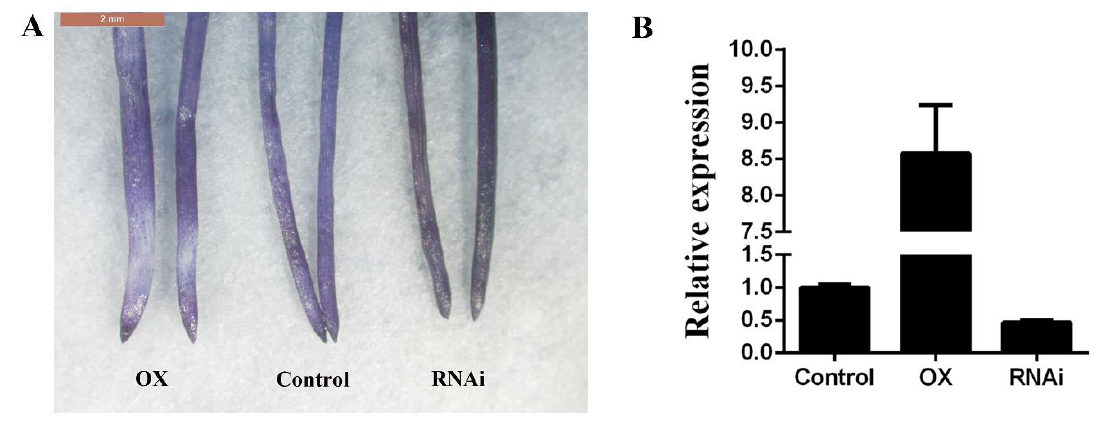
Figure 6. Hematoxylin staining in soybean hairy roots. ( A ) Hematoxylin staining in soybean hairy roots. ( B ) The RNA molecular level identification. OX, GsGIS3 -overexpressing transgenic soybean hairy roots; RNAi, GsGIS3 -RNAi in soybean hairy roots; Control, Agrobacterium rhizogenes pathogenic strain K599 in soybean hairy roots. Three independent biological experiments were carried out to investigate the status of seedlings and measure the root data.